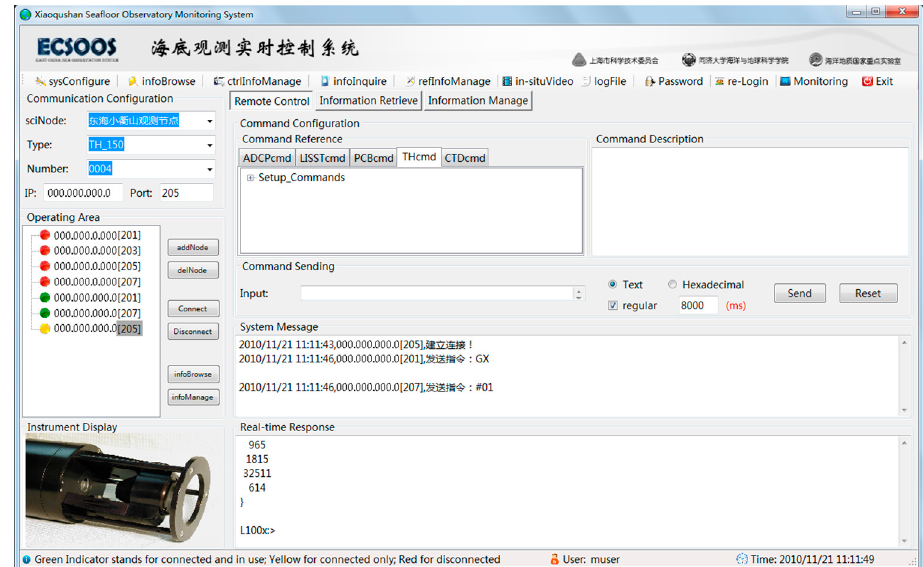
Figure 8. Tank Test for ESOCS.